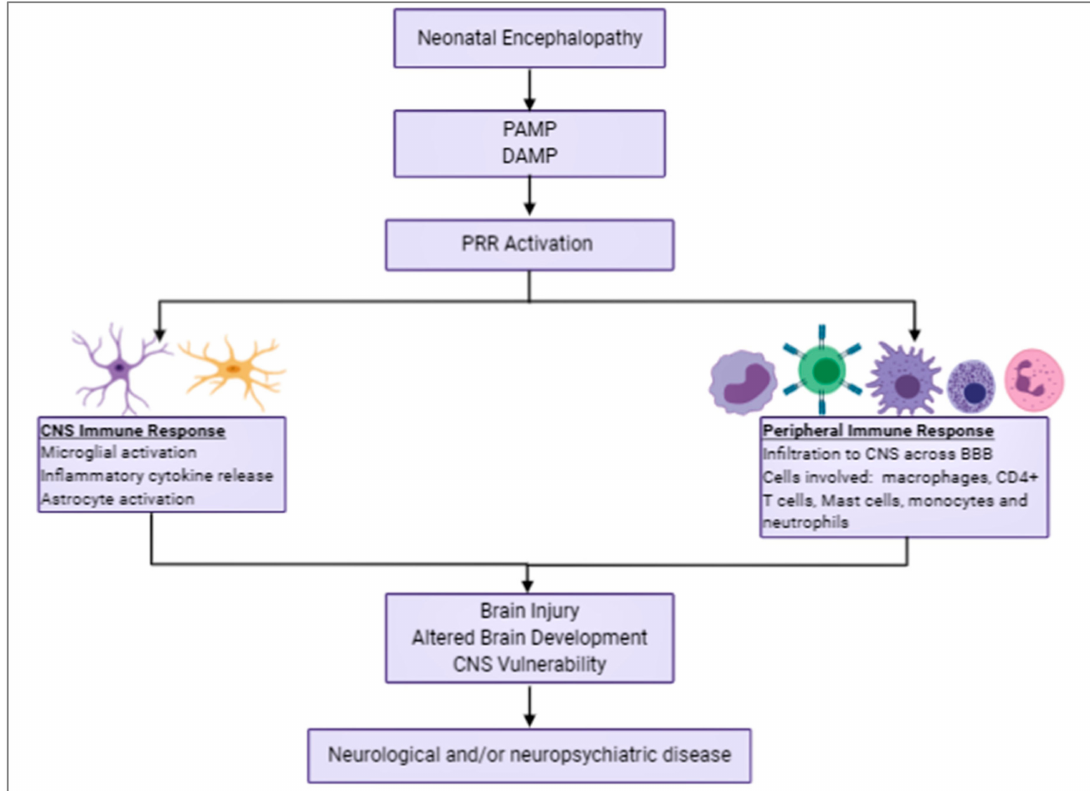
Figure 2. Summary of the inflammatory processes that occur following neonatal encephalopathy (NE), highlighting the cell types involved from both the CNS and peripheral immune response along with the ramifications of NE that persist long after this inflammatory response